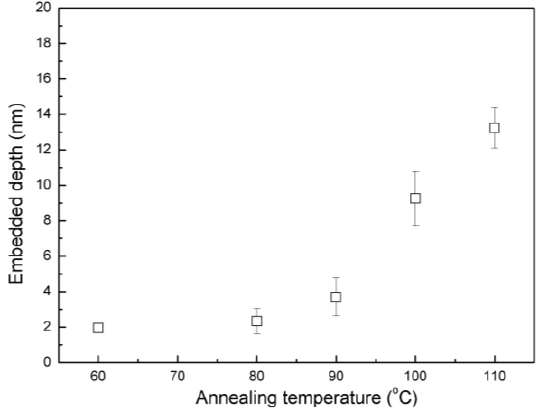
Figure 4. Embedded depth of 20 nm gold nanoparticle into 120 nm PS film in vacuum at various annealing temperature.